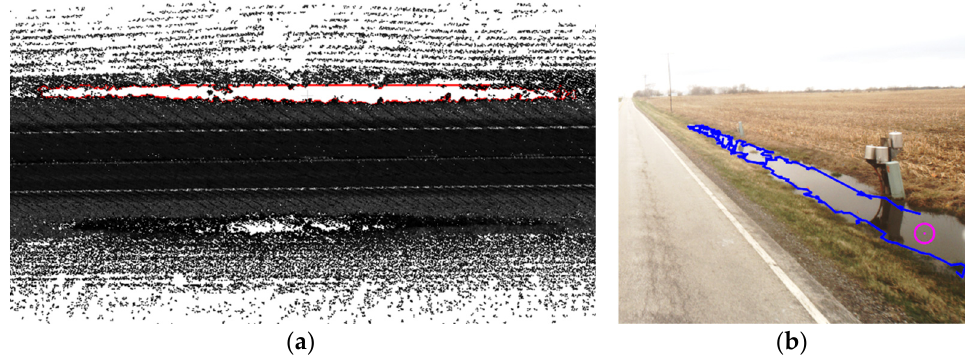
Figure 22. An example of potential flooded region visualized in: ( a ) 3D point cloud and ( b ) 2D image.